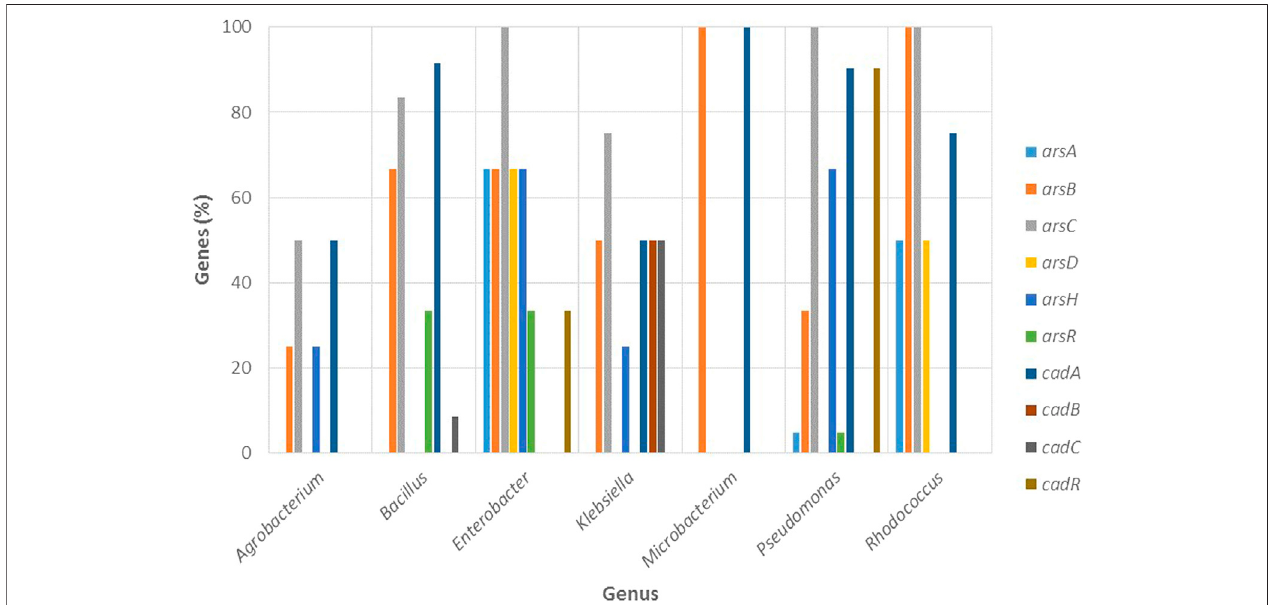
FIGURE9| Percentage ofgenesinvolved inarsenicand cadmium resistance infunctionofthemostresistantbacterial genera ( Agrobacterium,Bacillus,Klebsiella, Enterobacter, Microbacterium, Pseudomonas, and Rhodococcus ).